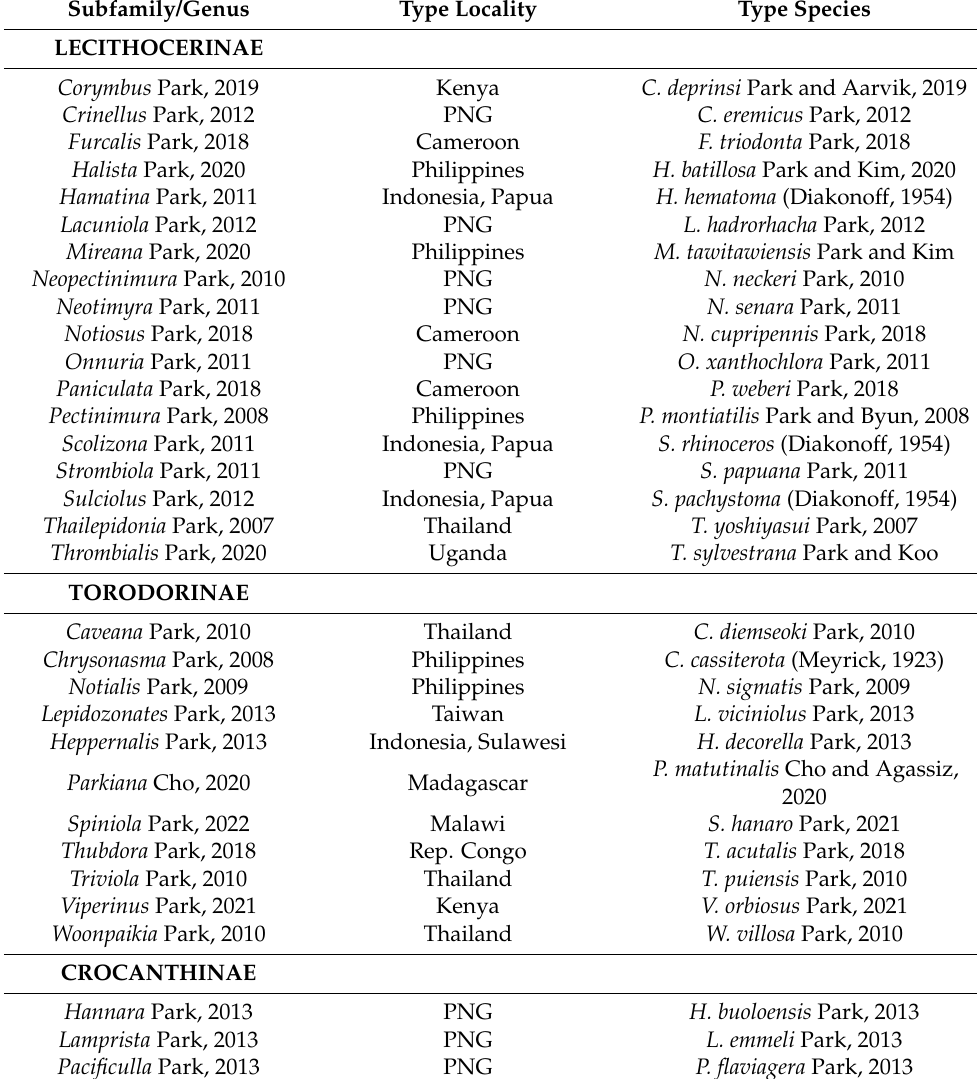
Table 3. New genera of the family Lecithoceridae described during last two decades.